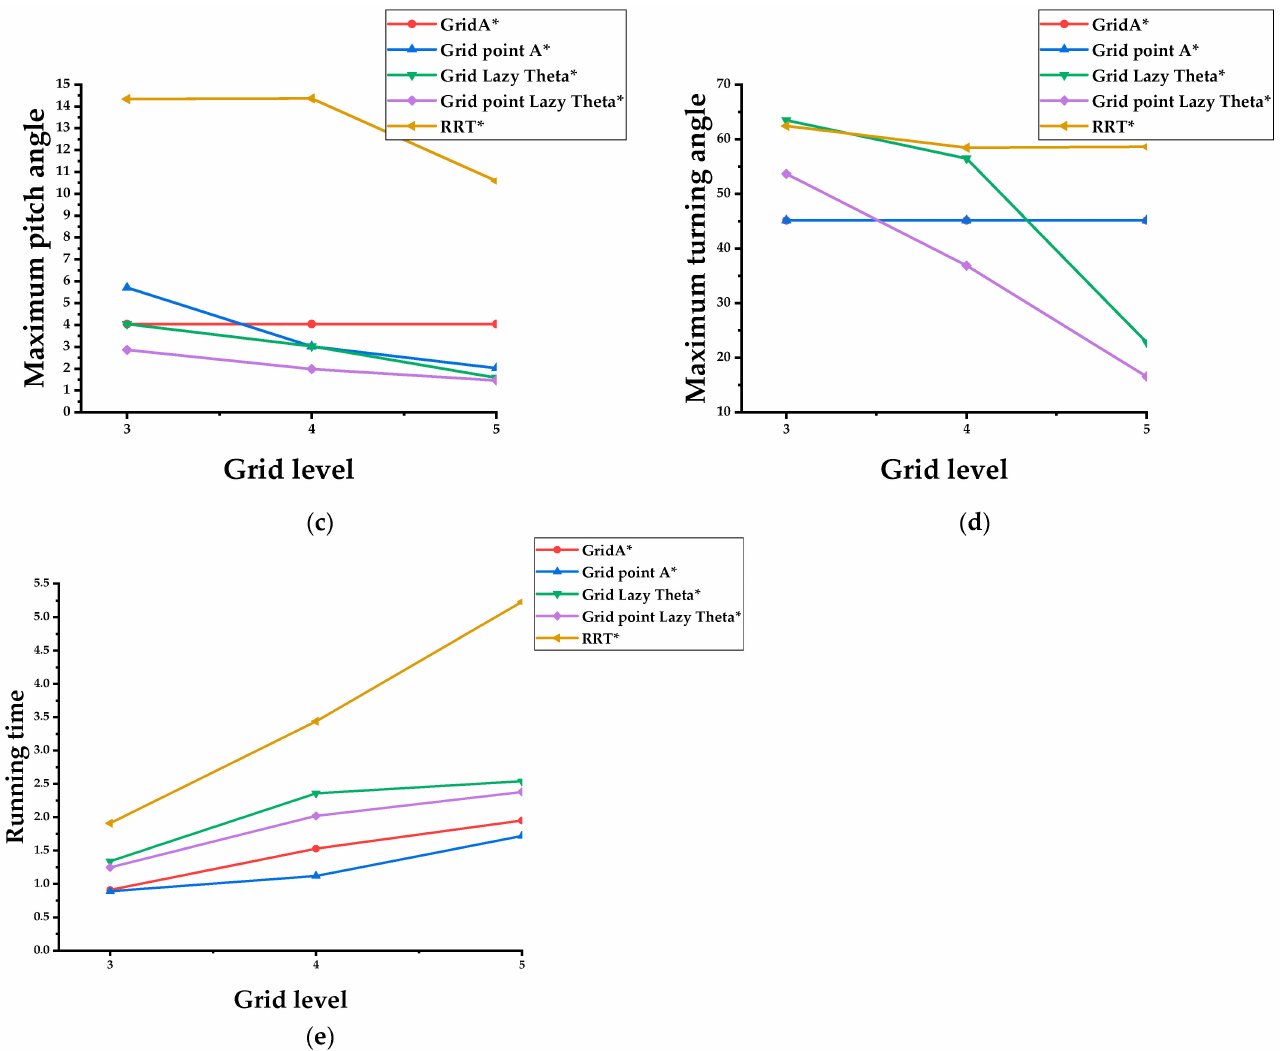
Figure 20. Route planning algorithm data comparison chart. ( a ) Path length comparison, ( b ) Path cost comparison, ( c ) Maximum pitch angle comparison, ( d ) Maximum turning angle comparison, and ( e ) Running time